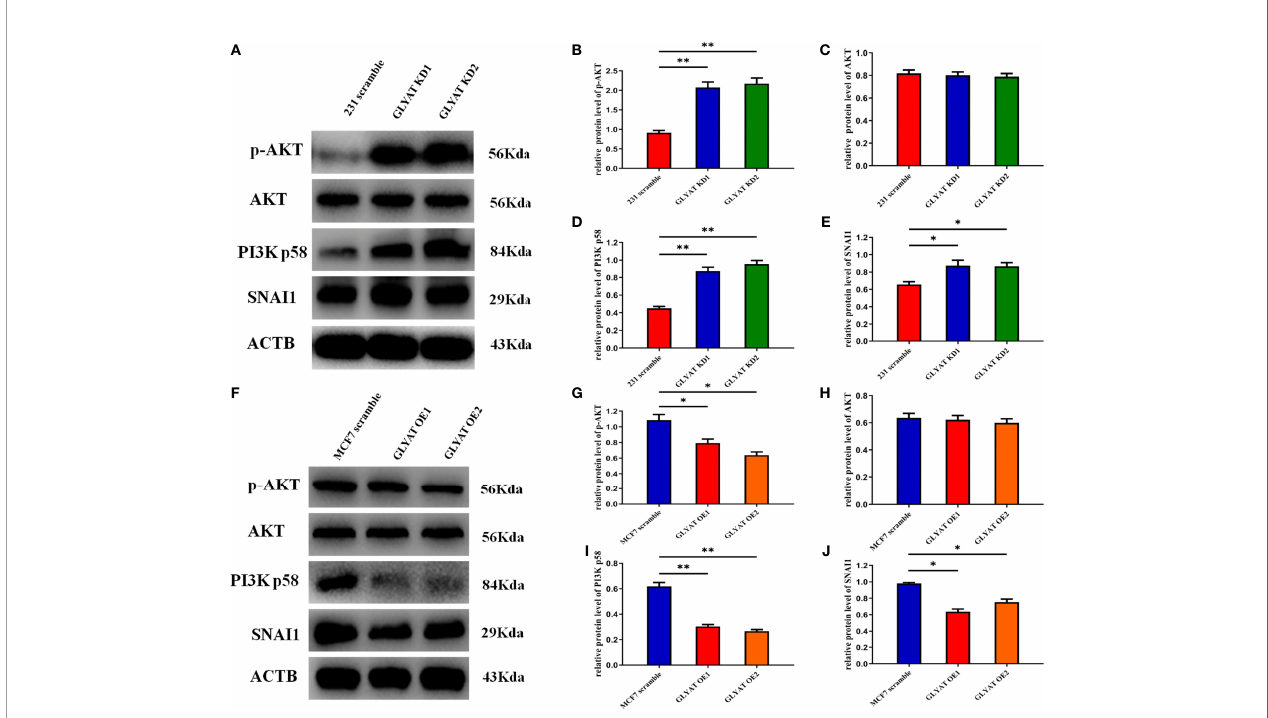
FIGURE 4 | GLYAT regulated breast cancer cells EMT progression through PI3K/Akt signaling Pathway. (A – E) Protein levels of p-AKT,AKT, PI3K and SNAI1 were signi fi cantly activated in GLYAT KD MDA-MB-231 cells. (F – J) Protein levels of p-AKT,AKT, p-PI3K and SNAI1 were signi fi cantly reduced in GLYAT over expressed OE MF-7 cells. * p < 0.05, ** p < 0.01, and p < 0.05 was considered to be statistically signi fi